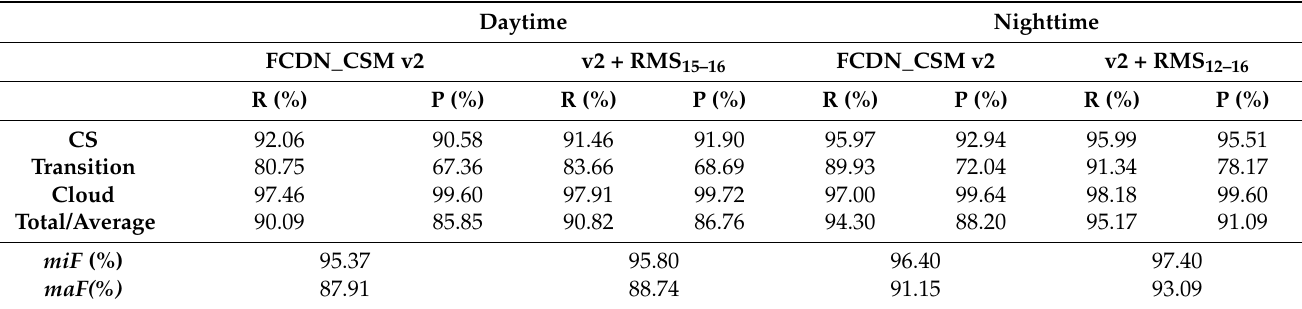
Table 8. Prediction accuracies for test data using FCDN_CSM v2 or FCDN_CSM v2 plus new RMS feature as Clear-Scheme 2. RMS: FCDN_CSM v2 plus new RMS feature).